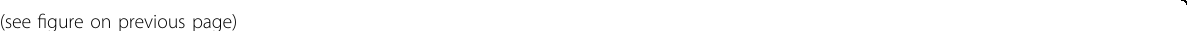
Fig. 3 Connectivity analysis revealing signals from SFRP4 + stroma cells promote endometrial epithelial organoid proliferation in vitro. a Heatmap shows the total numbers of receptor-ligand interactions from any of the two sub-populations from the microenvironment of full- thickness human uterus in proliferative phase. b Clustering of the interactions of ligands (uniquely expressed in proliferative endometria) from each cell sub-population of the proliferative endometria to receptors from the proliferative epithelial cell sub-population. c Heatmap shows expression of ligands uniquely expressed in proliferative phase of the human endometria derived from another transcriptional dataset of the human endometria during the menstrual cycle (GSE4888). d immuno fl uorescence staining of co-expression with SFRP4 and CD10 in cultured human endometrial stromal cells, scale bar, 100 μ m. e Percentage of SFRP4 and CD10 double positive cells in each high-power fi eld. n = 6. f organoids culturing of endometrial epithelia cells with or without SFRP4 + stroma co-cultured, scale bar, 200 μ m. g quanti fi cation of endometrial epithelial organoids at different time points of co-cuture, * p < 0.05; *** p < 0.001. h diameter of endometrial epithelial organoids at different time points of co-cuture, *** p <